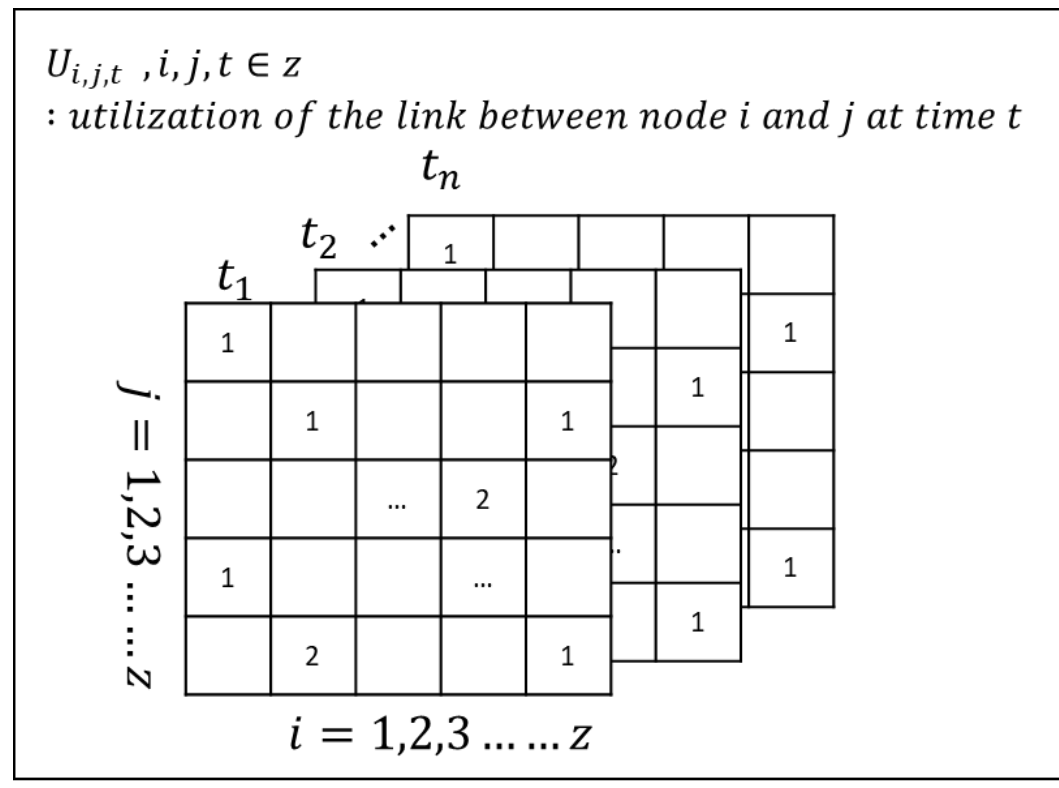
Figure 5. Architecture of CNN-LSTM (SCL).